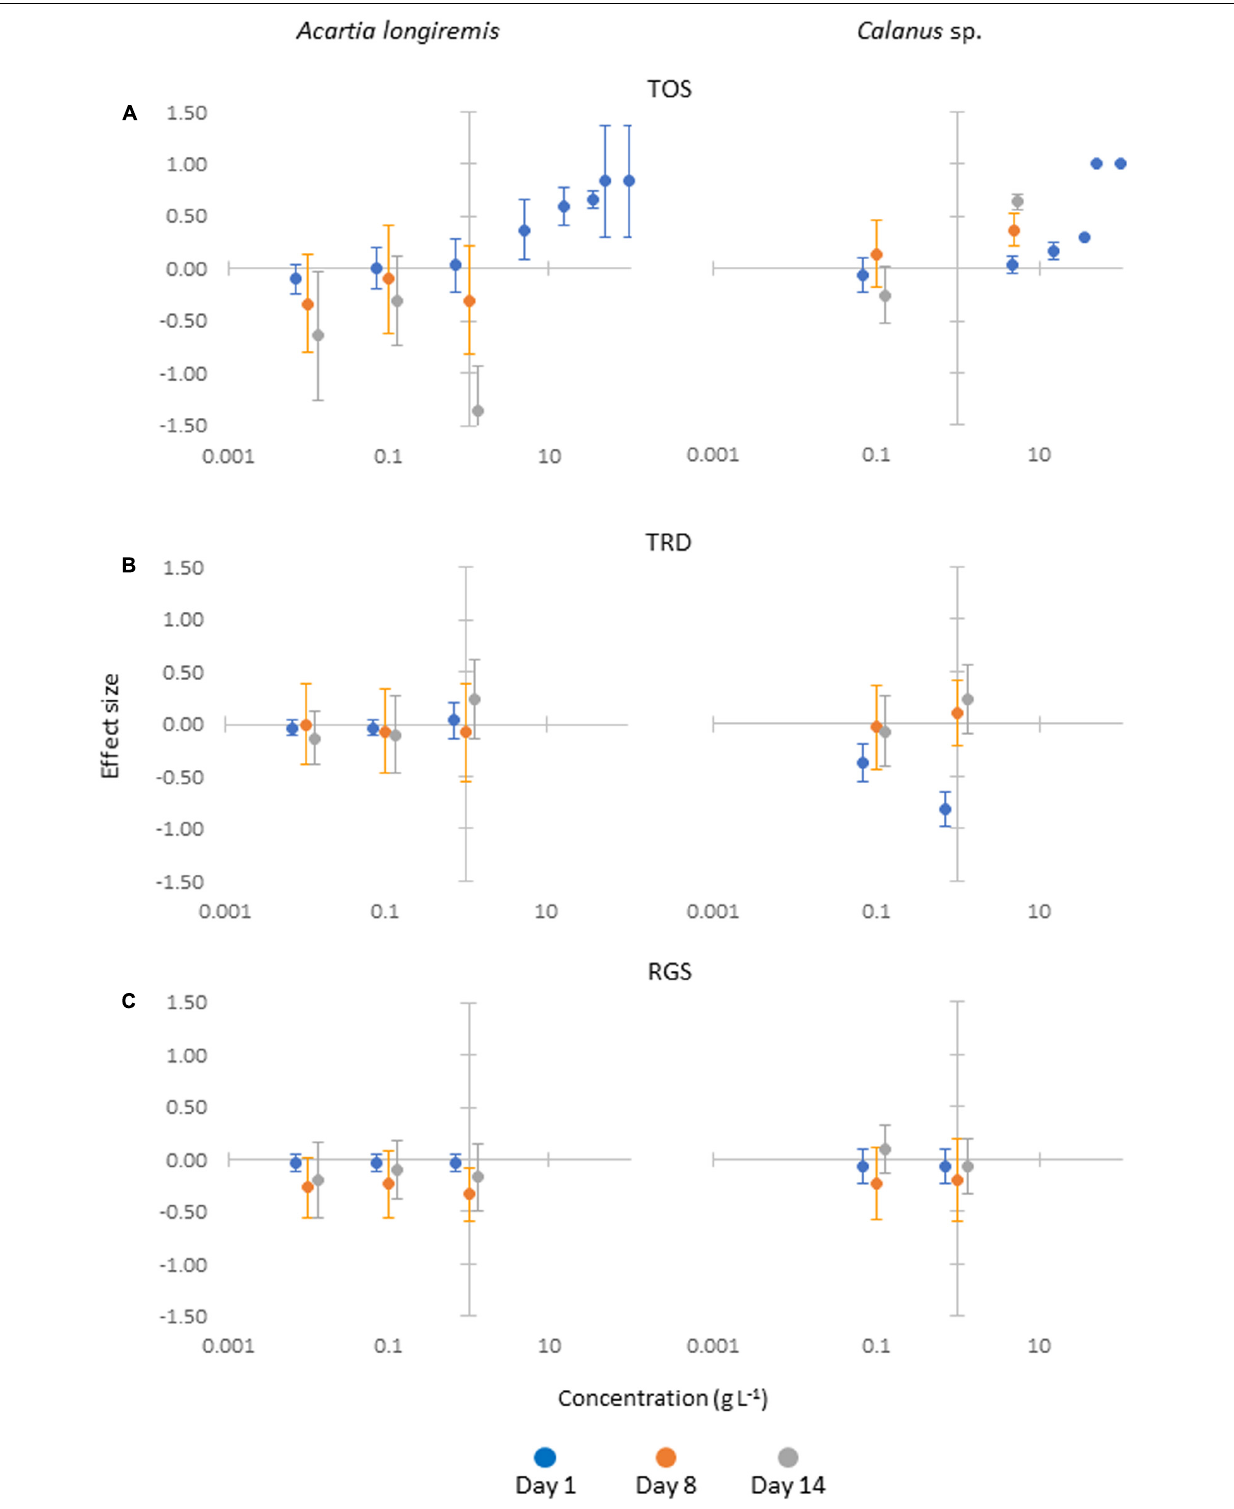
Frontiers in Environmental Science |